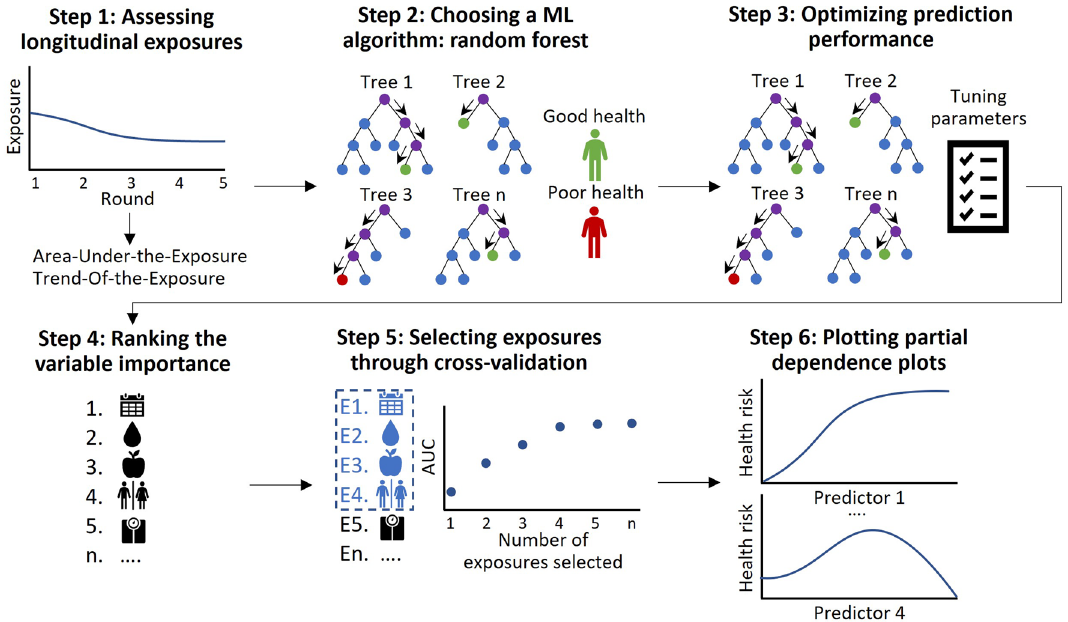
Figure 2. Summary of the six analysis